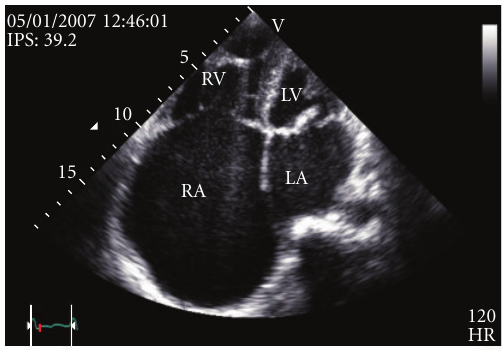
Figure 1: Chest radiography with a marked cardiomegaly suggest- ing massively dilated right atrium (RA). Cardio thoracic ratio was 89%.